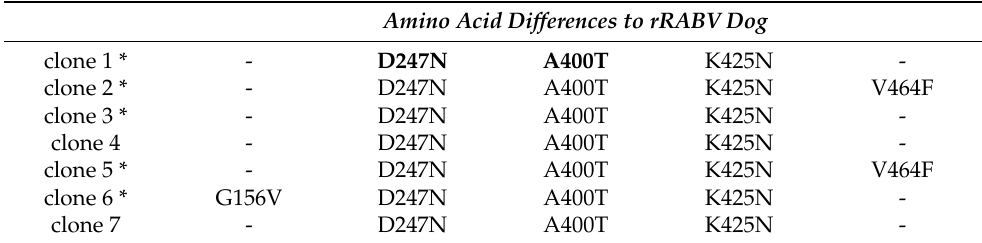
Table 2. Combination of mutations in G gene cDNAs cloned from rRABV DogB-P10. Indicated are aa substitutions with respect to the original rRABV Dog